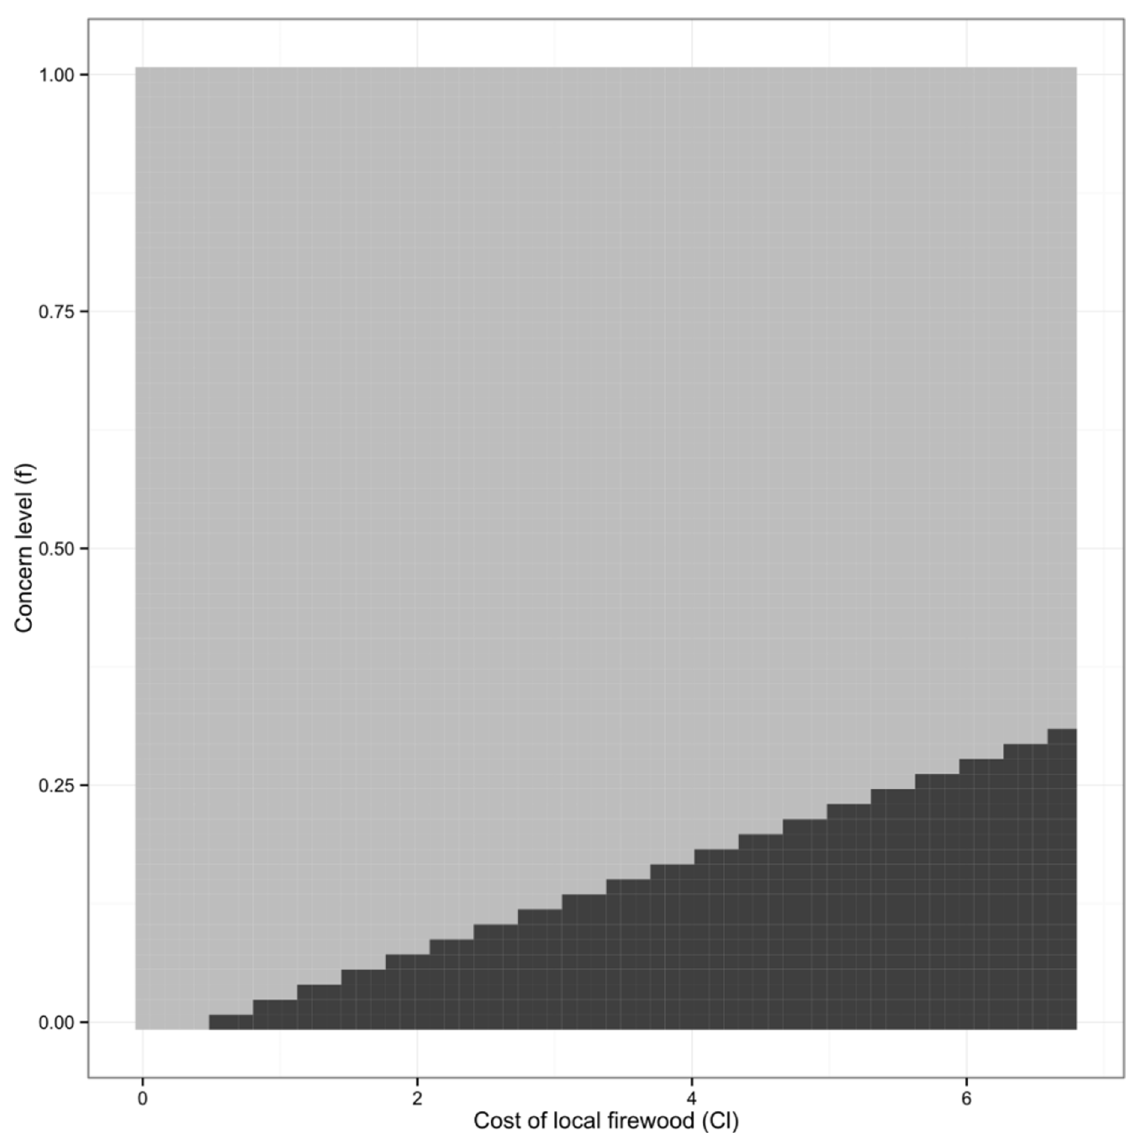
Figure 7. Phase portrait of relationship between concern and cost of local firewood. Phase portrait for simultaneous changes to concern level (f) and local cost of firewood (Cl). The dark region represents containment of the infestation while the light region represents continued spread.